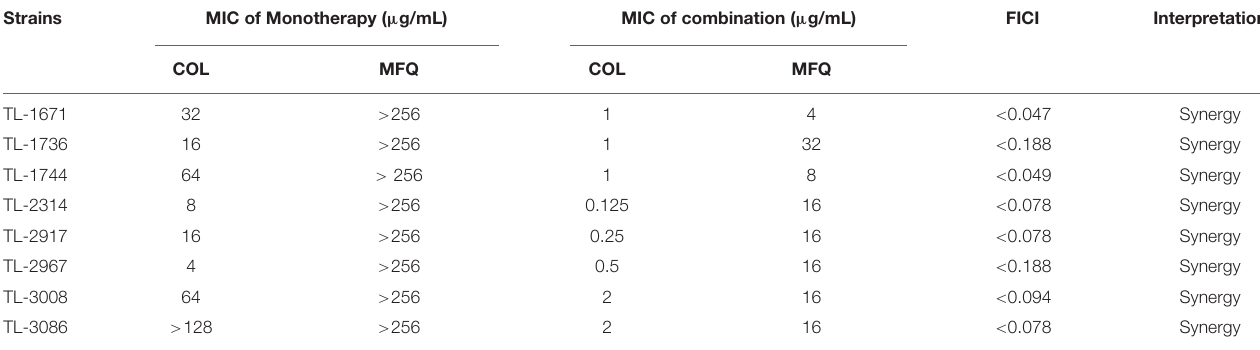
TABLE 2 | FICI value for colistin/mefloquine combinations against colistin-resistant Pseudomonas aeruginosa strains. Strains MIC of Monotherapy ( µ g/mL) MIC of combination ( µ g/mL) FICI